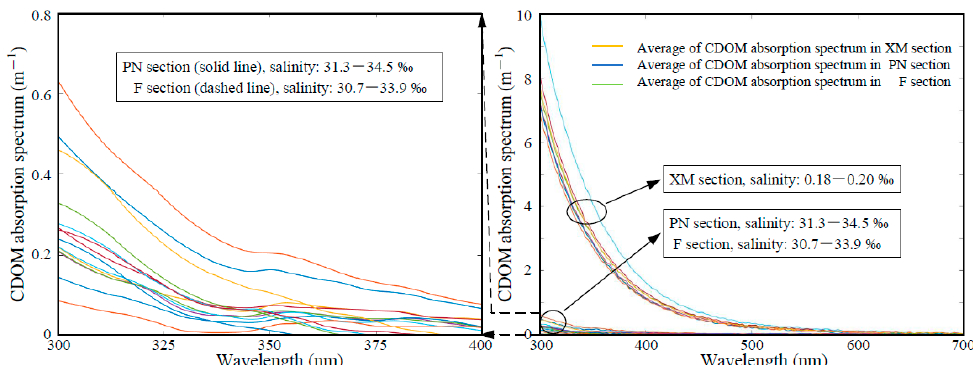
Figure 3. Absorption spectral curves for the chromophoric dissolved organic matter (CDOM) in all three sections. There are distinct differences between the slopes of the dataset for section XM and those of sections PN and F.